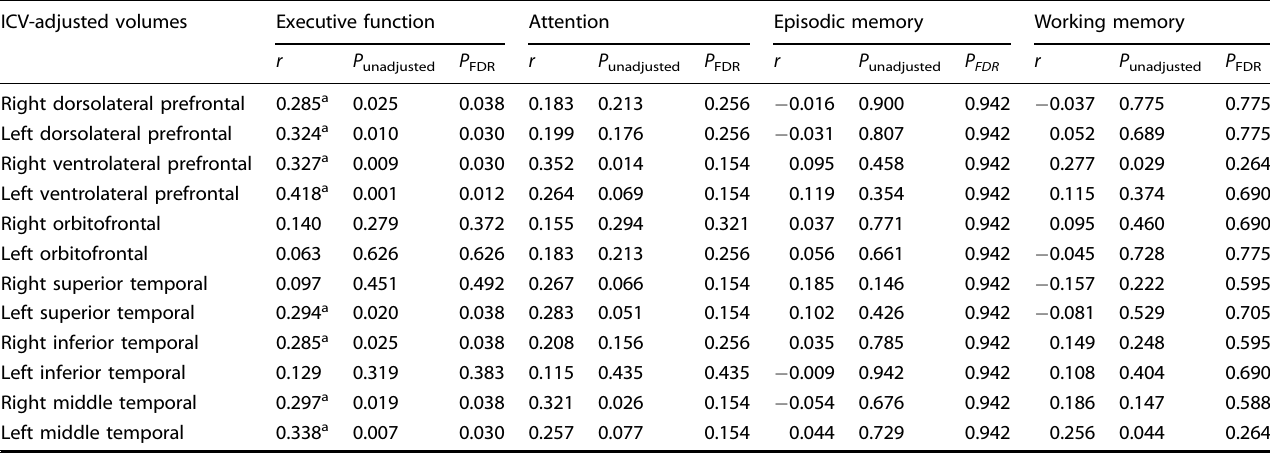
Table 2. Correlations Between Cognitive Scores and ICV-adjusted volumes in SZH (controlling for duration of illness, education and medication). ICV-adjusted